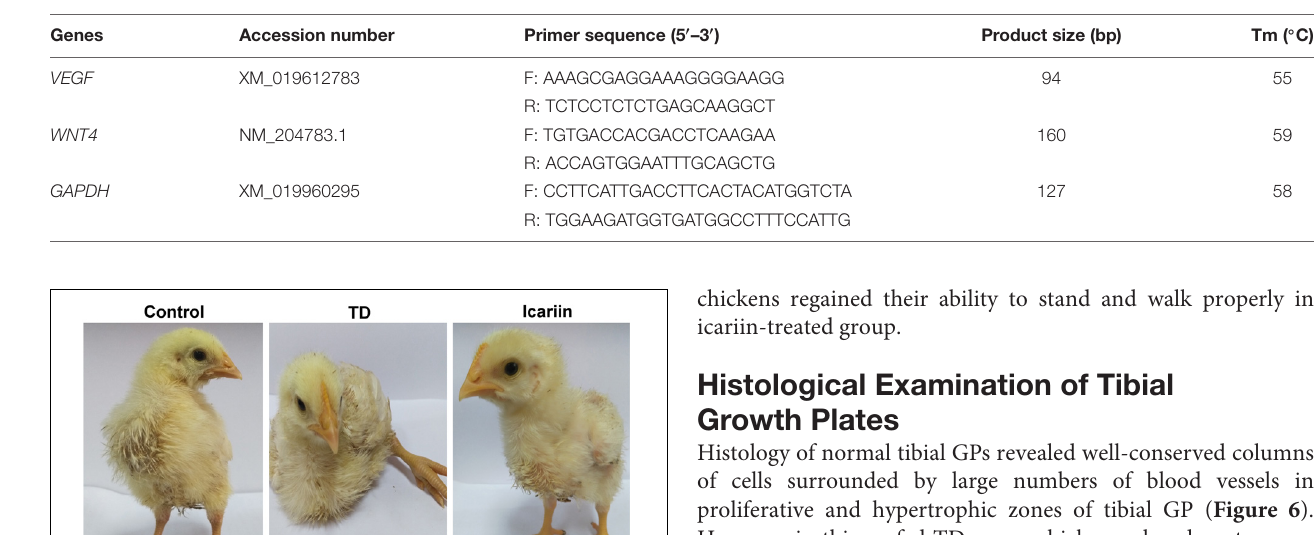
TABLE 1 | Primers used for the quantitative polymerase chain reaction.